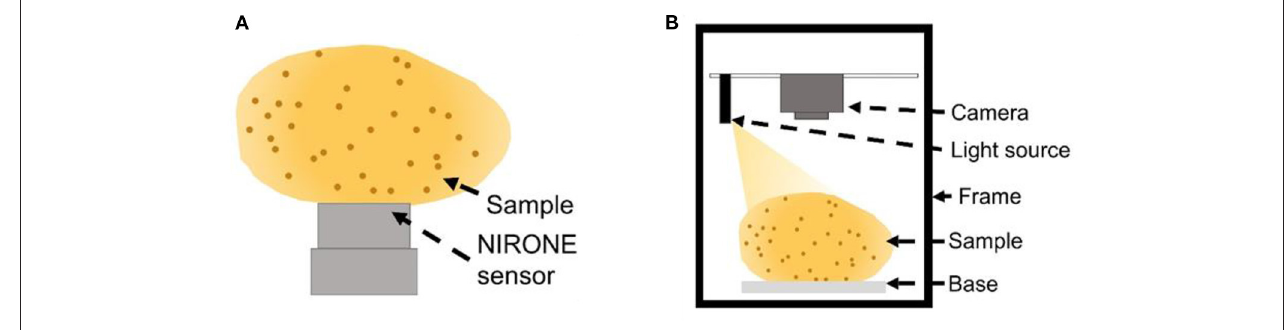
TABLE 4 | Best regression and classification results of dry matter for whole tubers and sliced samples obtained from different utilised NIR sensors. System